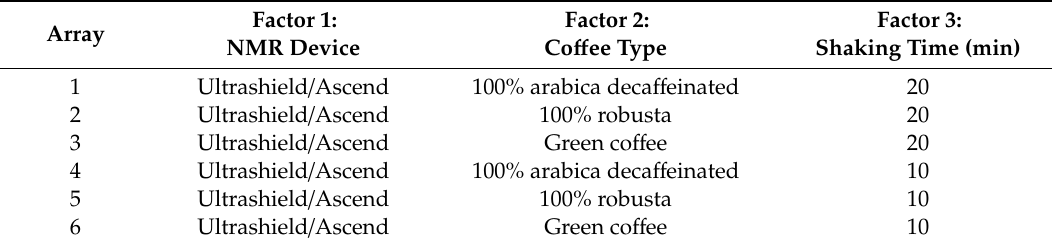
Table 2. Factorial experimental design